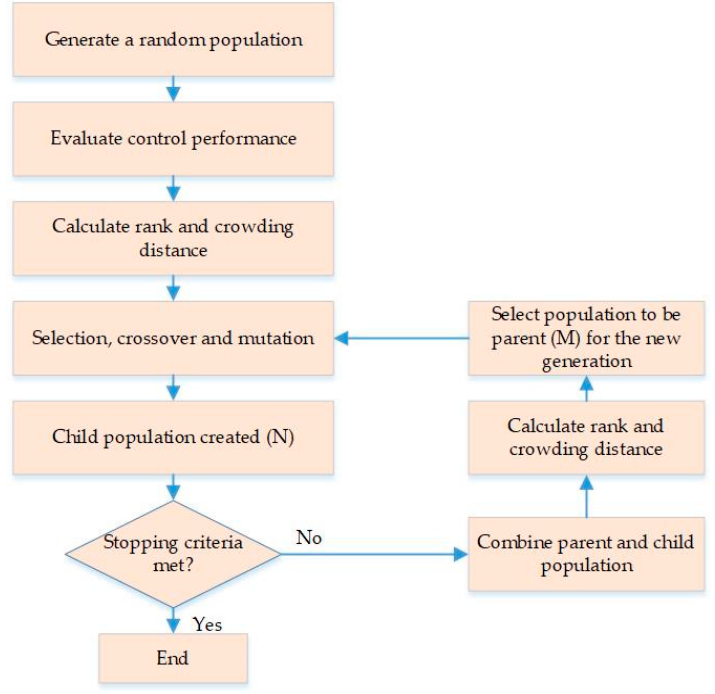
Figure 10. Flowchart of non-dominated sorting genetic algorithm (NSGA)-II.